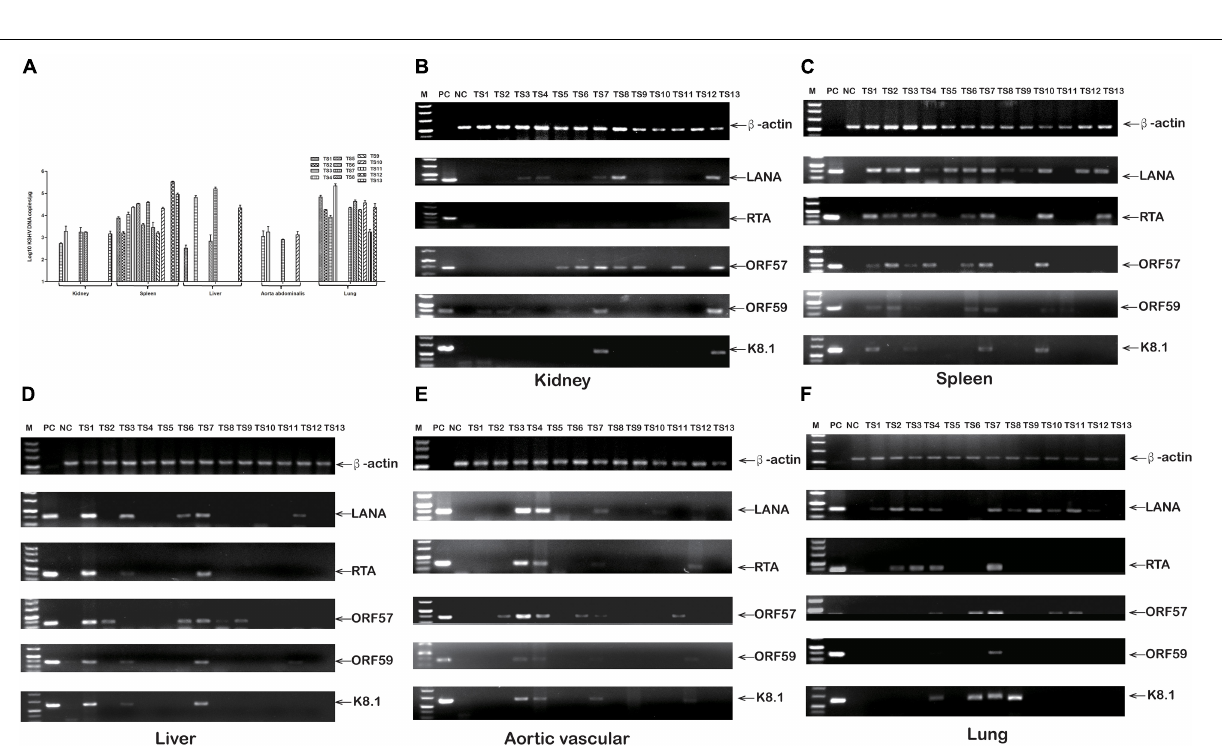
Frontiers in Microbiology |